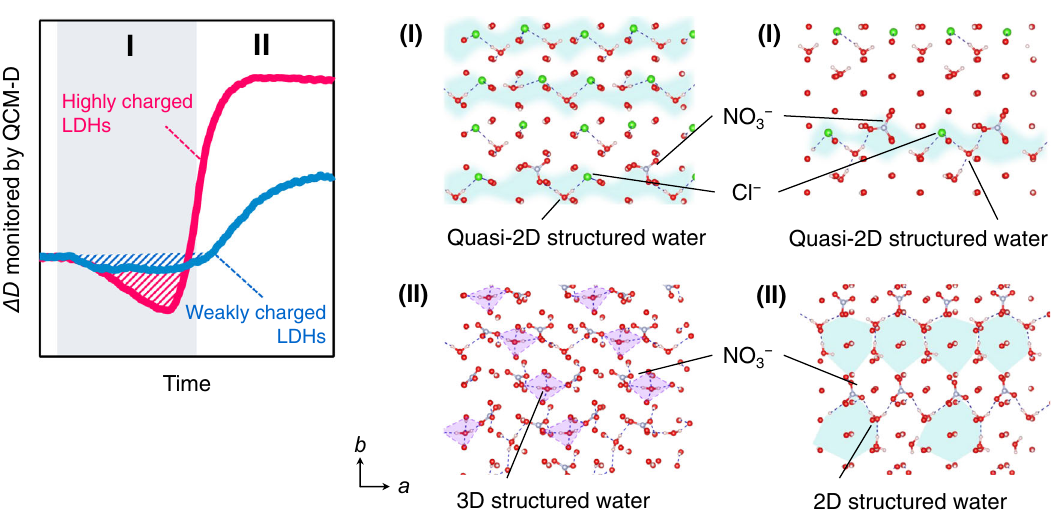
Fig.6|Thecriticalroleofinterlayer fi llingdensityofionsandstructuredwater on nitrate ion storage in LDHs. The role is further decomposed, combining the obtained QCM-D pro fi les with the theoretical calculations. In the high interlayer fi lling densityenvironment of the highly chargedLDHs, quasi-2Dstructuredwater formed in the early storage regime (I) facilitates strong interlayer interactions, while the 3D structured water in the latter storage regime weakens the interlayer